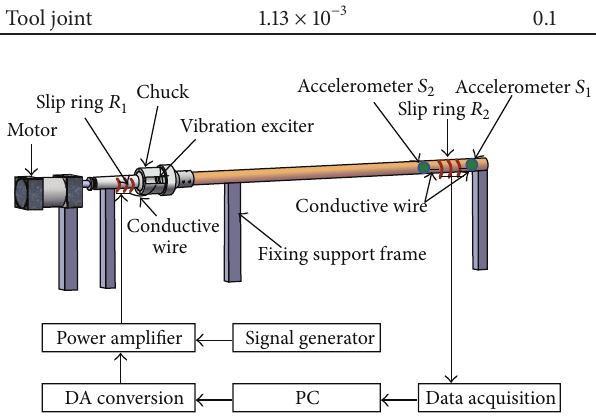
Figure 8: Schematic diagram of the established experimental rig.